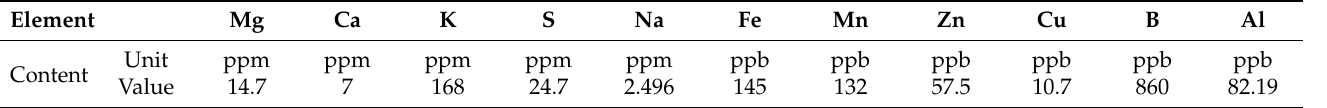
Table 2. ICP-OES ion analysis